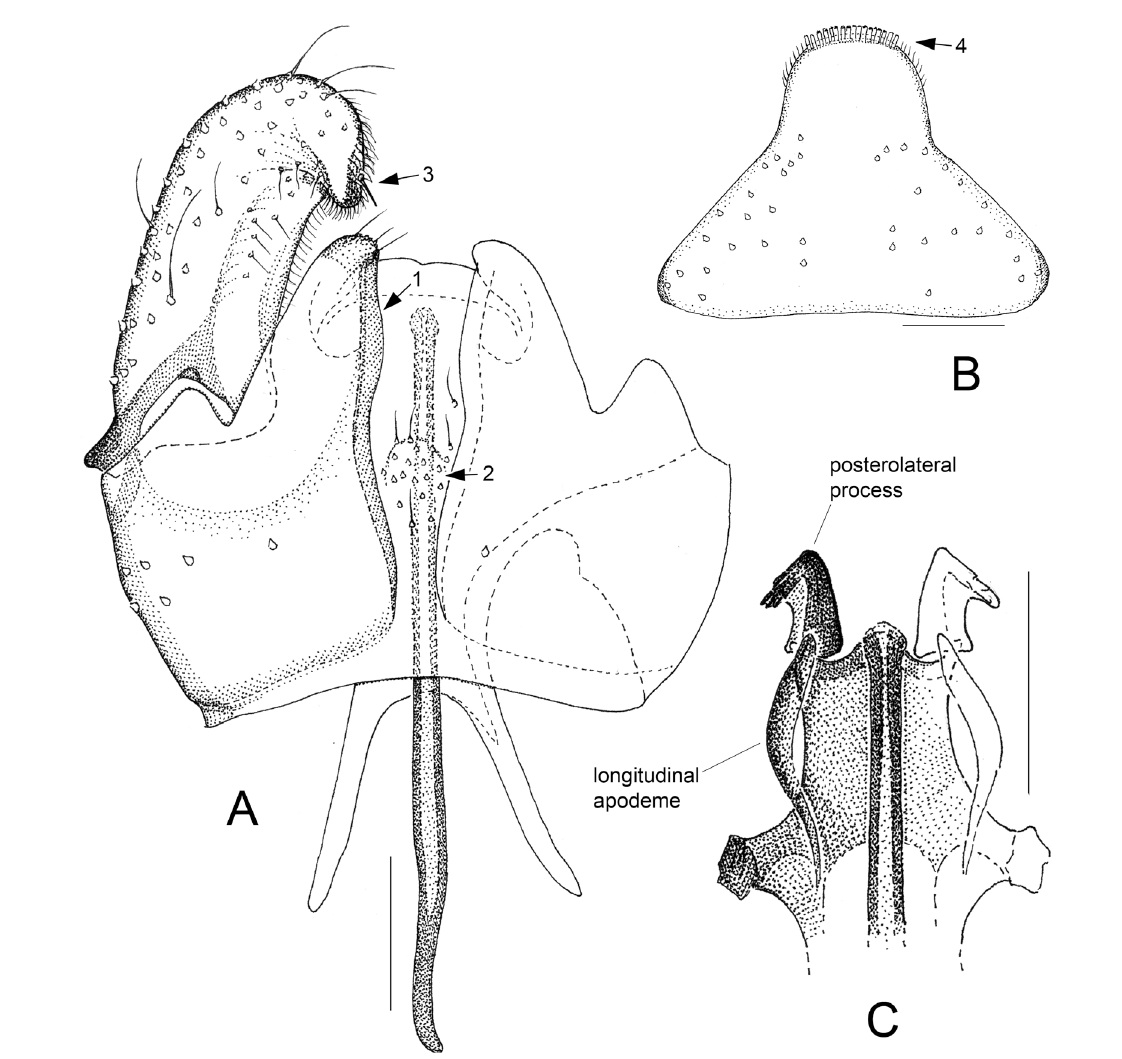
Fig. 15. Glemparon rotoroa sp. nov., ♂♂. A , C . holotype (NZAC, no. CEC1415). A . Genitalia, ventral. B . Ninth tergite, dorsal, paratype (NZAC, no. CEC1416). C . Apex of ejaculatory apodeme and tegmen, ventral. Scale bars = 0.05 mm. Numbered arrows indicate diagnostic characters (see